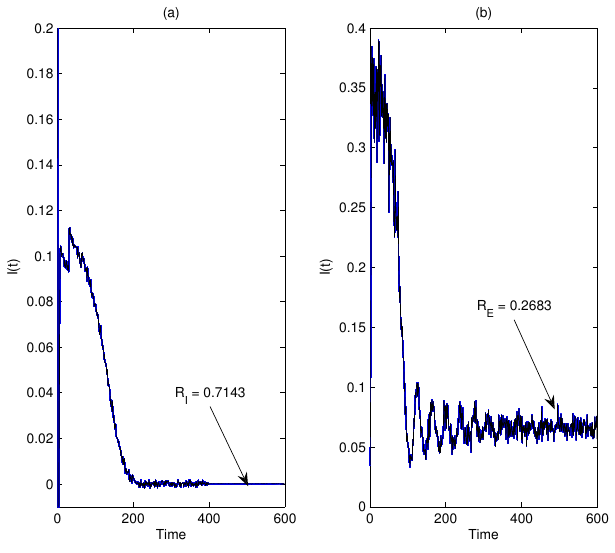
√ Figure 4. If σ i 1 ( n ) = 0.04 + 0.01sin n , σ i 2 ( n ) = 0.1 + 0.05sin n ( i = 1,2,3,4 ) , c 1 ( u ) = 0.5, c 2 ( u ) = 0.03, c 3 ( u ) = 0.02, c 4 ( u ) = 0.05 and initial value ( 0.4,0.1,0.05,5 ) , dynamical responses of the infected individual I ( t ) are shown in ( a , b ), respectively. It can be obtained that R I = 0.7143 < 1, which follows that infectious disease becomes extinct exponentially. In other words, if c 1 ( u ) = 0.5, c 2 ( u ) = 0.02, c 3 ( u ) = 0.01, c 4 ( u ) = 0.03, then it can be obtained that R E = 0.2683 > 0, which follows that infectious disease persists in mean.